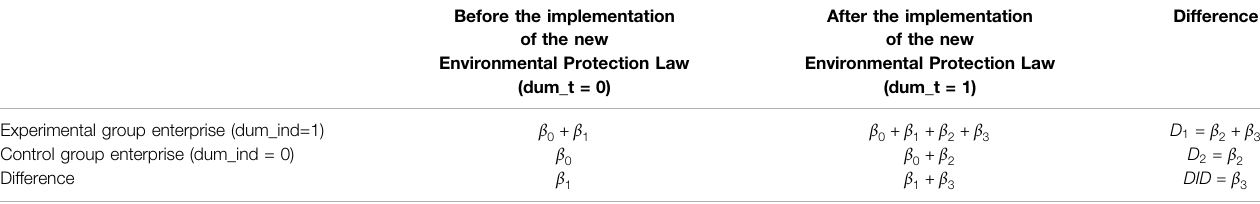
TABLE 2 | Double difference (DID) model.